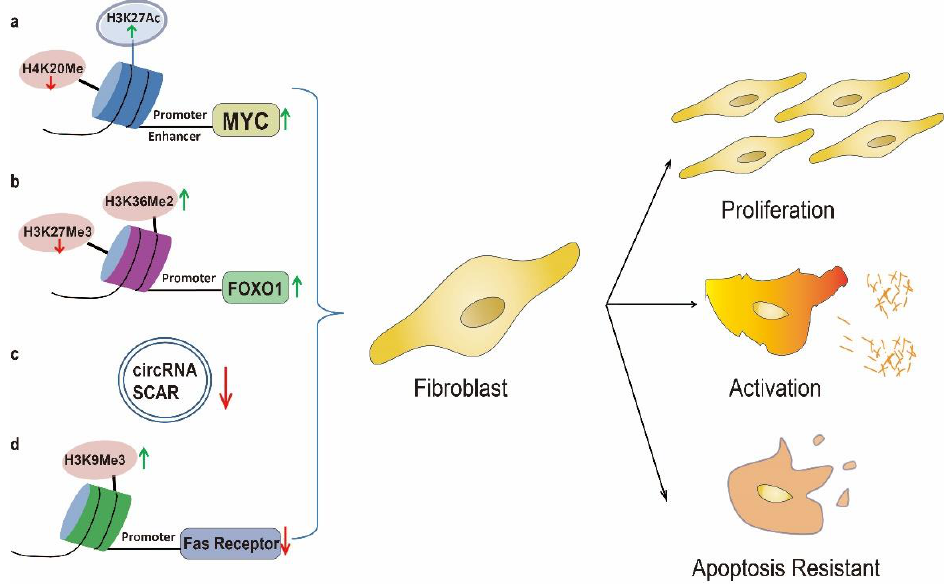
Figure 2. HFD facilitates the proliferation, over activation and apoptosis resistant through epige- netic modification. a: HFD could enhance MYC transcriptional through enhancing H4K20 hypo- methylation and H3K27Ac at the promoter regions which promotes lung fibroblast proliferation; b: HFD rich in PA could activate Foxo1 through increasing H3K36Me2 and decreasing H3K27Me3 on promoter region which is crucial for activated fibroblast to secret collagen in the progression of lung fibrosis; c: HFD could decrease mitochondrial circRNA SCAR to facilitate fibroblast activa- tion; d: PA could promote H3K9Me3 which is responsible for the decreased expression of the death receptor Fas thus facilitates fibroblasts resistance to apoptosis in fibrotic lung.